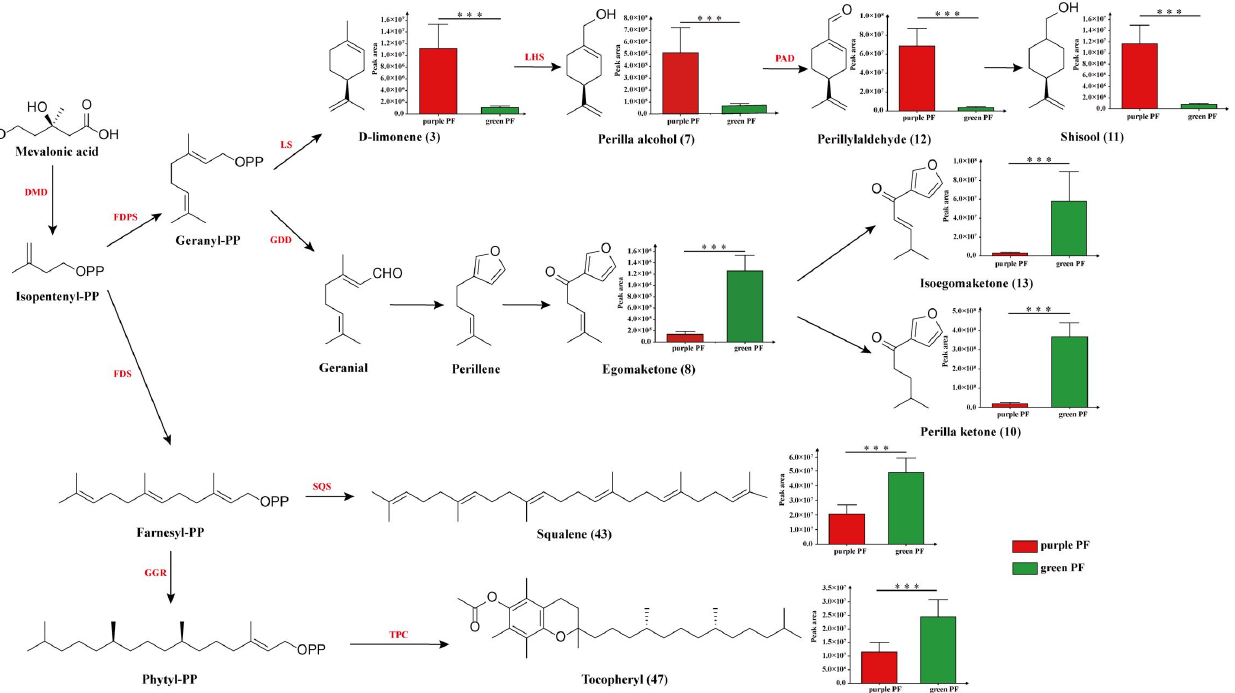
Figure 4. Putative biosynthetic pathways of the main terpenoids in perilla. Metabolites are written in black letters, whereas enzymes are written in red letters. DMD, diphosphomevalonate decarboxylase; FDPS, farnesyl diphosphate synthase; LS, limonene synthase; LHS, limonene hydroxylase; PAD, perillylalcohol dehydrogenase; GDD, geranyl diphosphate diphosphohydrolase; FDS, farnesyl diphosphate synthase; SQS, squalene synthase; GGR, geranylgeranyl reductase; TPC, tocopherol C-methyltransferase. *** P < 0.001.